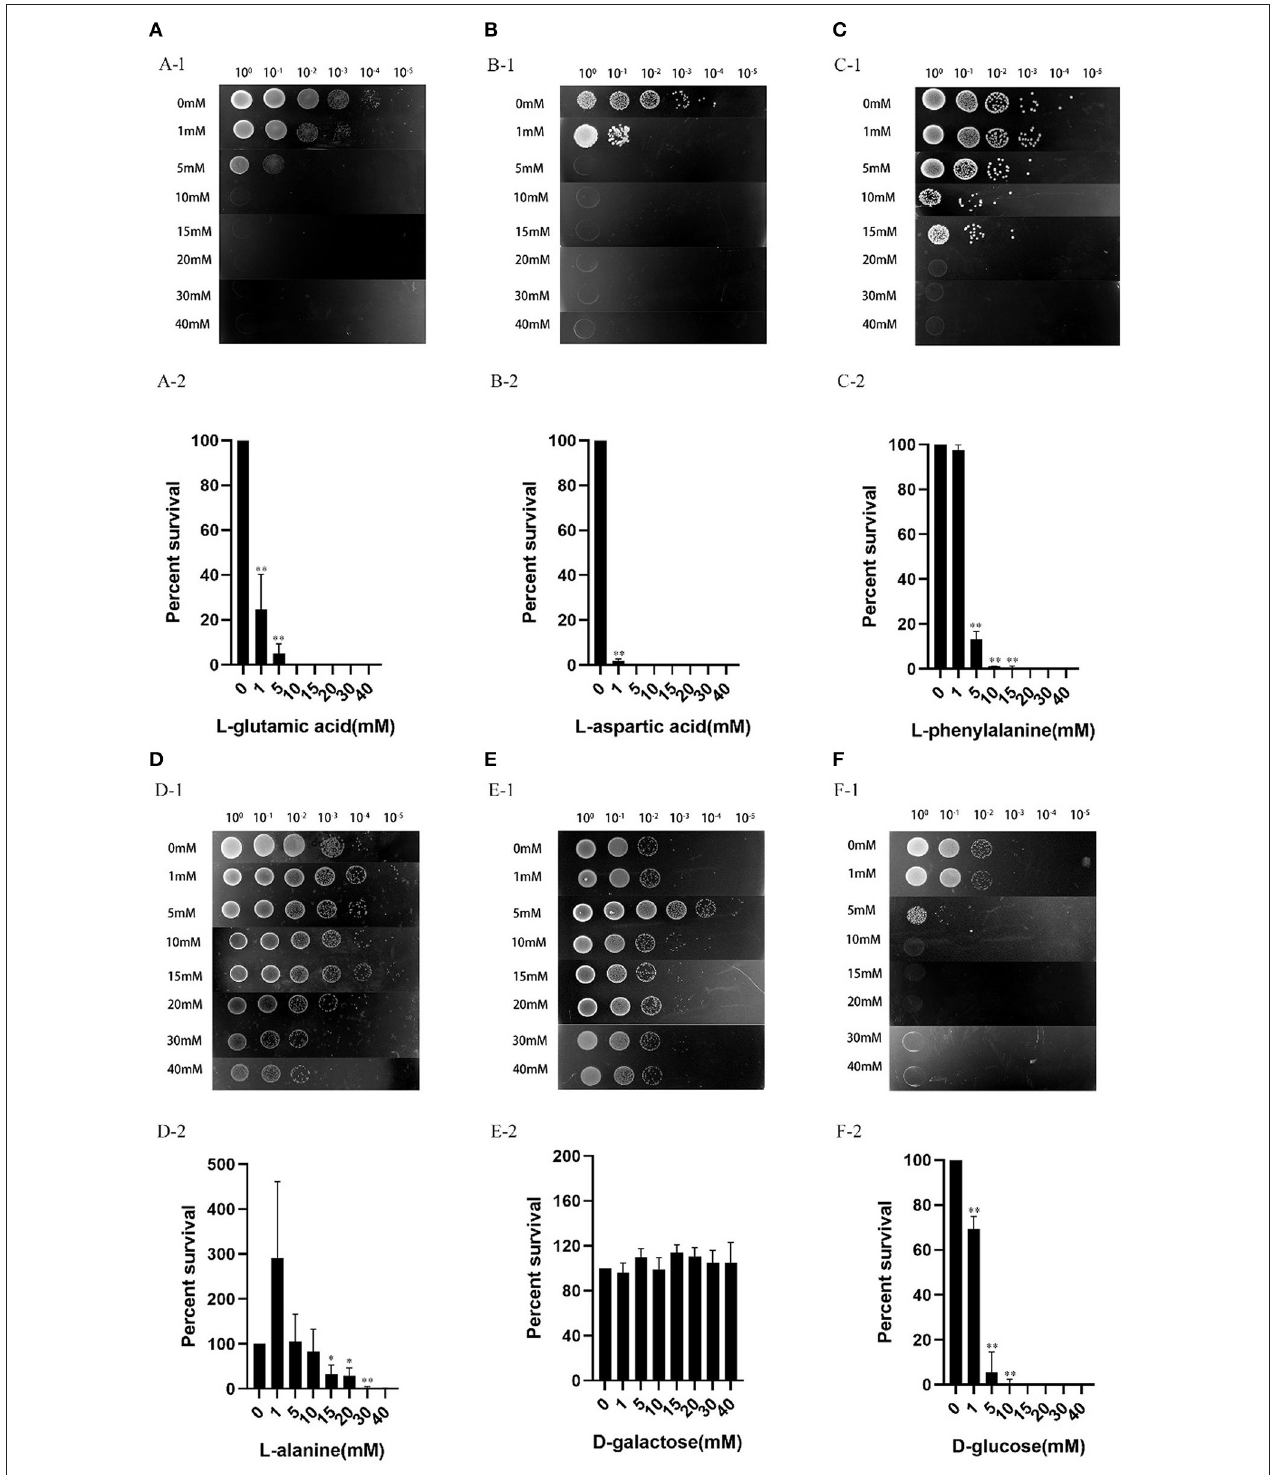
FIGURE 8 | Effects of exogenous carbon sources on antibiotic susceptibility of V. splendidus . The overnight grown stationary phase culture was supplemented with the following concentrations of exogenous metabolites: (A) L-glutamic acid, (B) L-aspartic acid, (C) L-phenylalanine, (D) L-alanine, (E) D-galactose, and (F) D-glucose. The cultures without addition of any exogenous carbon sources were used as a control. The antibiotics and exogenous carbon sources were simultaneously added to the culture and incubated for 6h, and the survived cells in different dilutions was represented by the colony formed on the plates (10 0 , 10 − 1 , 10 − 2 , 10 − 3 , 10 − 4 , and 10 − 5 meant no dilution, 10-, 100-, 1,000-, 10,000- and 100,000- dilutions). The relative percent of survival was calculated as follows: the cell number after tetracycline plus exogenous carbon source challenge/the cell number after tetracycline challenge alone. * p < 0.05 and ** p < 0.01.